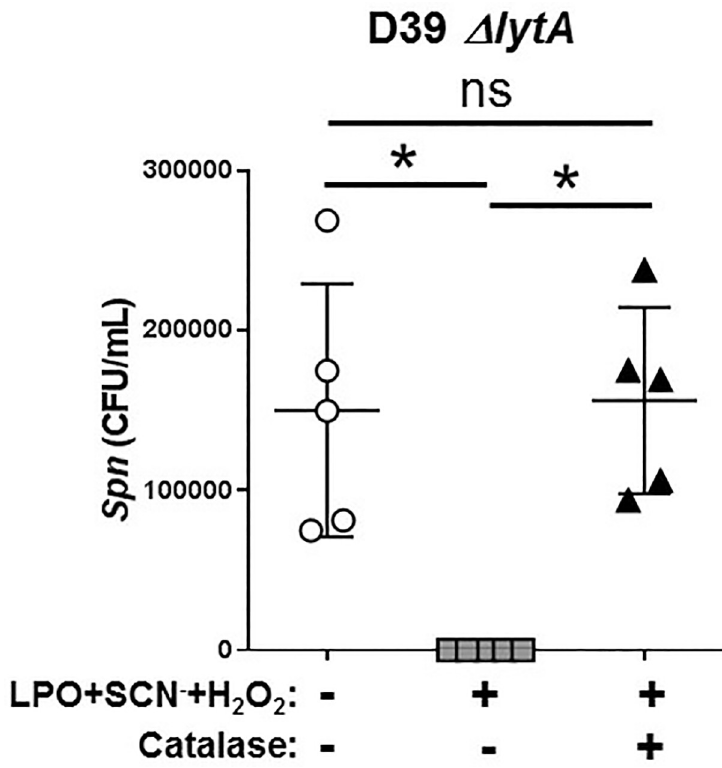
Fig 6. LytA-deficiency does not protect Spn against OSCN—mediated killing. OSCN — mediated killing of the lytA- deficient D39 Spn strain ( Δ lytA ) was tested in the cell-free system (n = 5). Bacteria were incubated for 6 hrs with or without OSCN - generated by the 1st line ™ and bacterial killing was quantified by colony counts on BAP. Each symbol represents a separate, individual experiment, mean+/-S.E.M. is shown. Mann-Whitney test. Each experiment was done in biological triplicates and each biological replicate was tested in technical triplicates. Ns, not significant; � , p < 0.05. CFU, colony-forming unit; LPO, lactoperoxidase; SCN - , thiocyanate; Spn , Streptococcus pneumoniae .